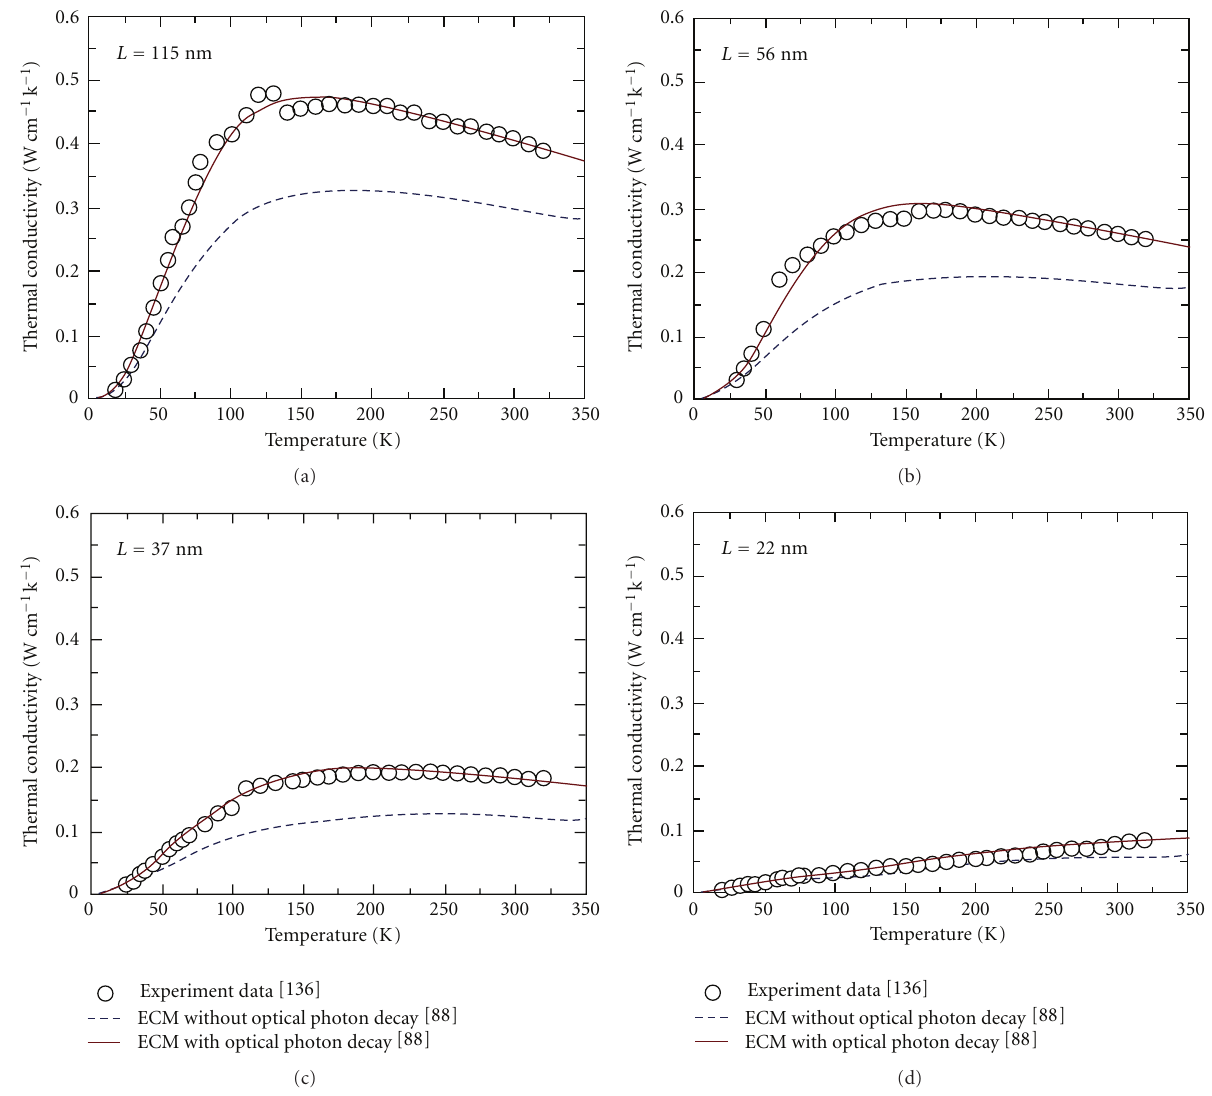
Figure 15: Thermal conductivity of individual Si nanowire. Symbols: experimental data [115]. Solid lines: elastic continuous model (ECM) which considers the optical phonons decay into acoustic phonons as acoustic phonon generation rate. Dashed lines: theoretical results obtained from ECM without accounting for the optical phonon